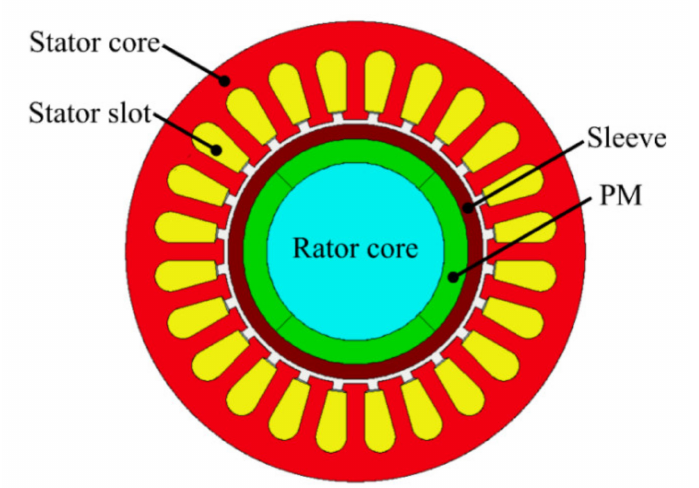
Figure 1. Structure of